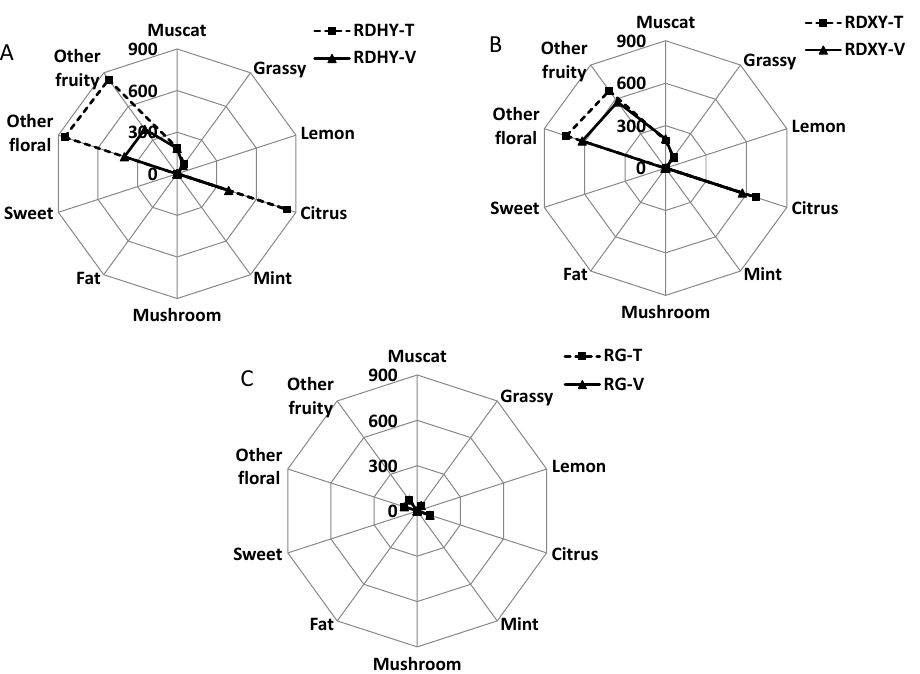
Figure 5. The aromatic profile of monoterpenes in three table grape cultivars under two trellis systems. Note: RDHY, ‘RuiduHongyu’; RDXY, ‘RuiduXiangyu’; RG, ‘Red Globe’; T, the T trellis system; V, the V trellis